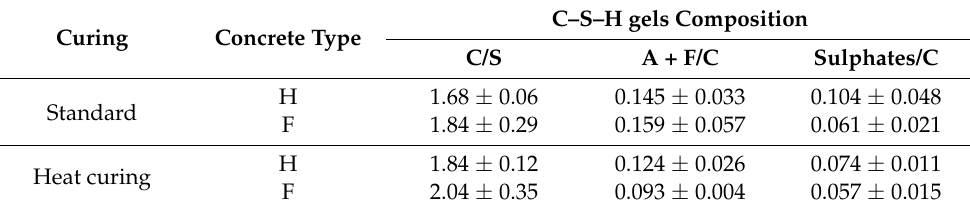
Table 1. Chemical composition of C-S-H gel formed in concrete under different conditions [60]. Curing.